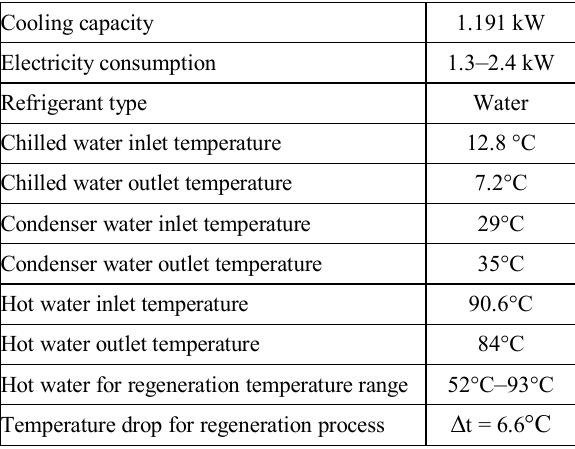
Table 2. Technical specification of BryAir chiller ADC Series F-FRAME F-330 [12].